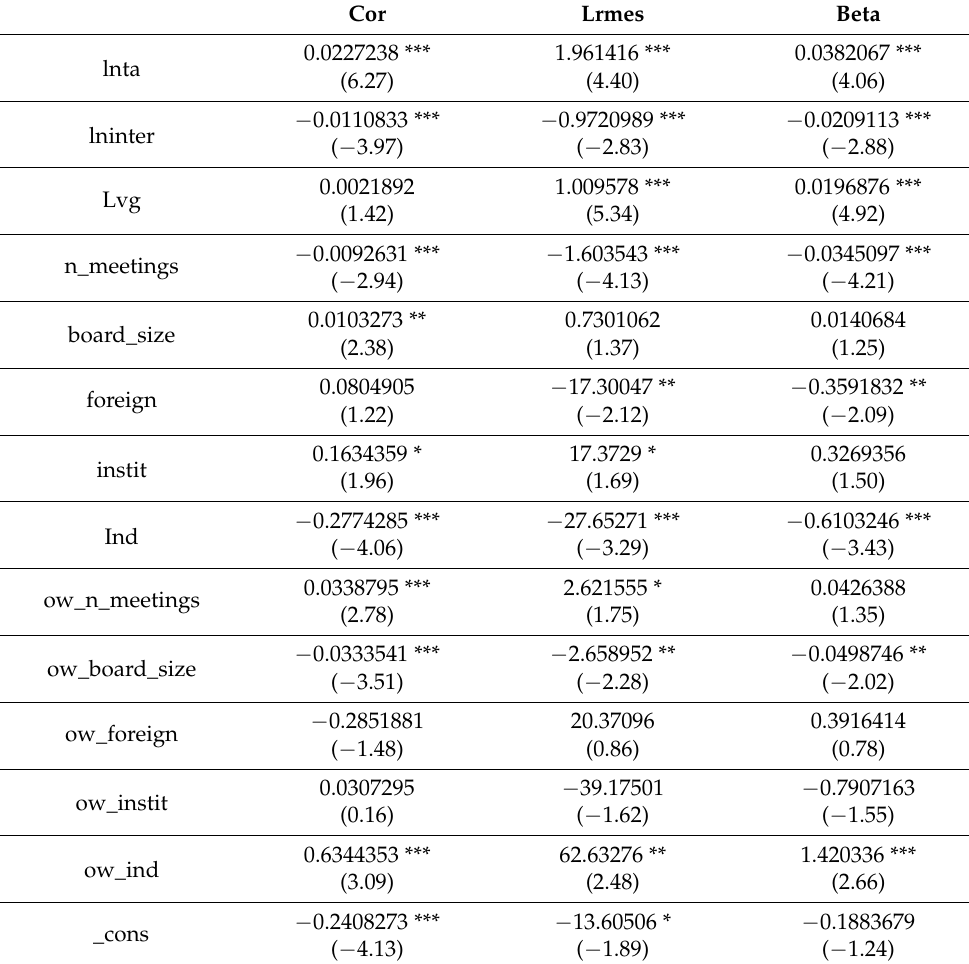
Table 6. Ownership structure and the relationship between systemic risk and corporate governance (three-stage least